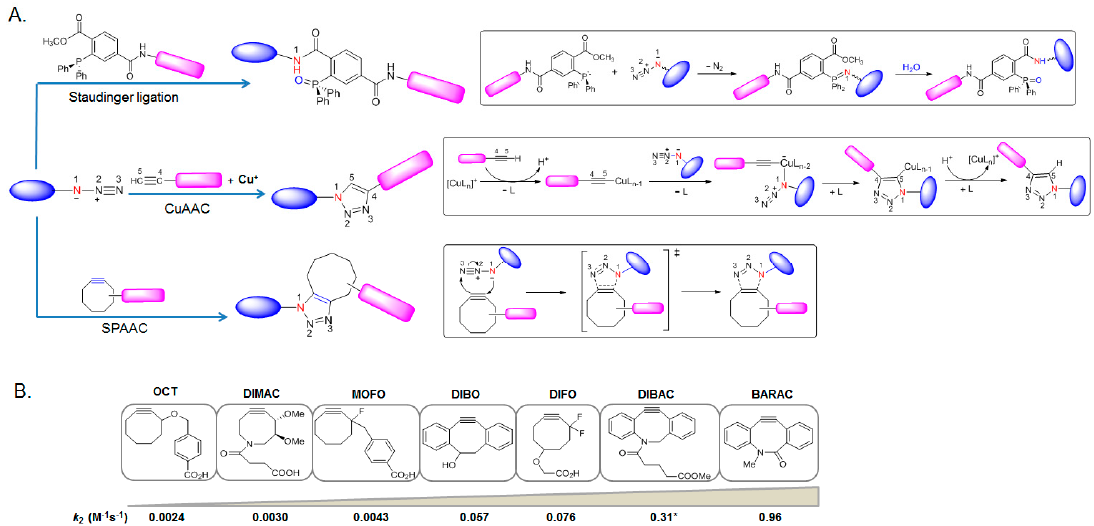
Figure 3. Bioorthogonal reactions with azide ( A ); and a series of cycoalkyne reagents developed for SPAAC with corresponding k 2 values for the 1,3-dipolar cycloaddition with benzyl azide ( B ). Simplified mechanistic views of each reaction (Staudinger ligation in the upper, CuAAC in the middle, SPAAC in the bottom in ( A )) are described in the box.